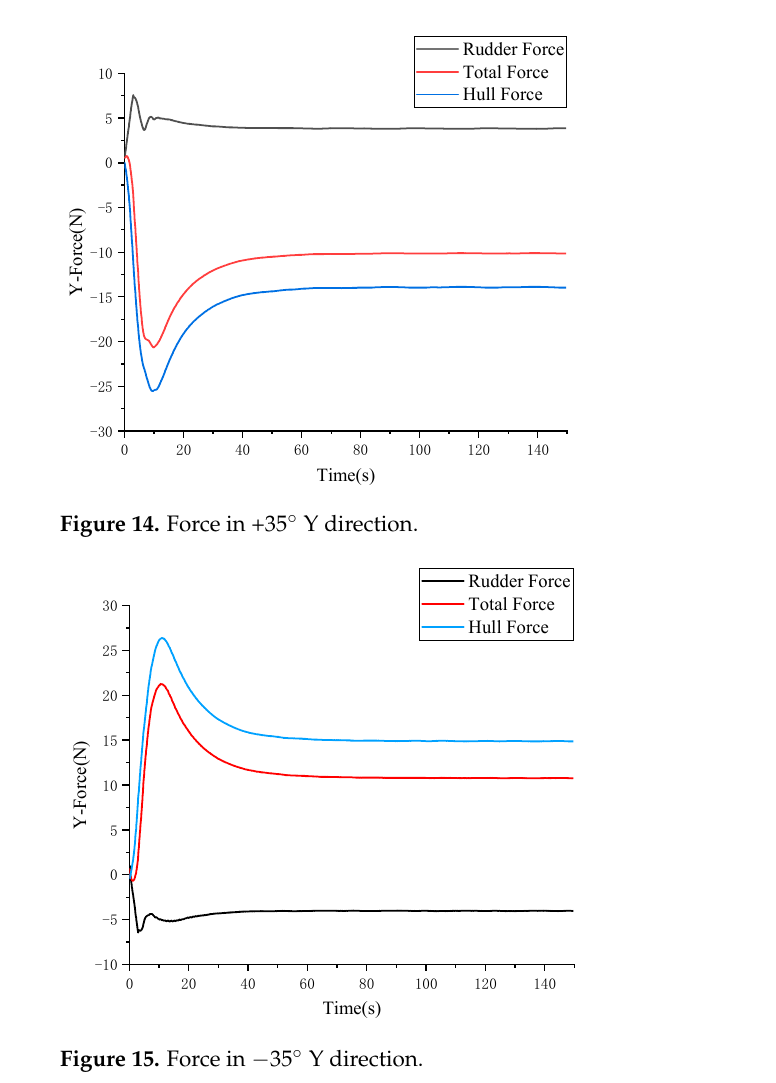
Figure 15. Force in − 35° Y direction Figure 16 shows the pressure on the rudder’s surface during the turning of the rudder